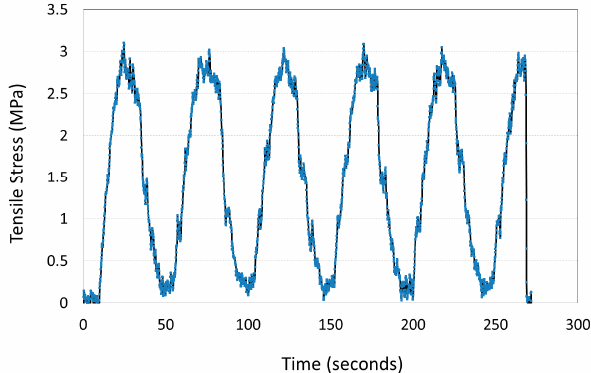
Figure 4. Cyclic loading on specimen No. 19 (failed during the 6th cycle).